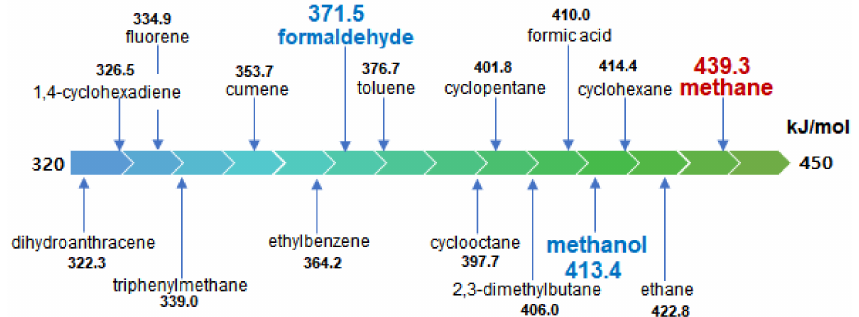
Figure 2. The first dissociation energies for the C-H bond of some hydrocarbons and reaction intermediates during partial oxidation of